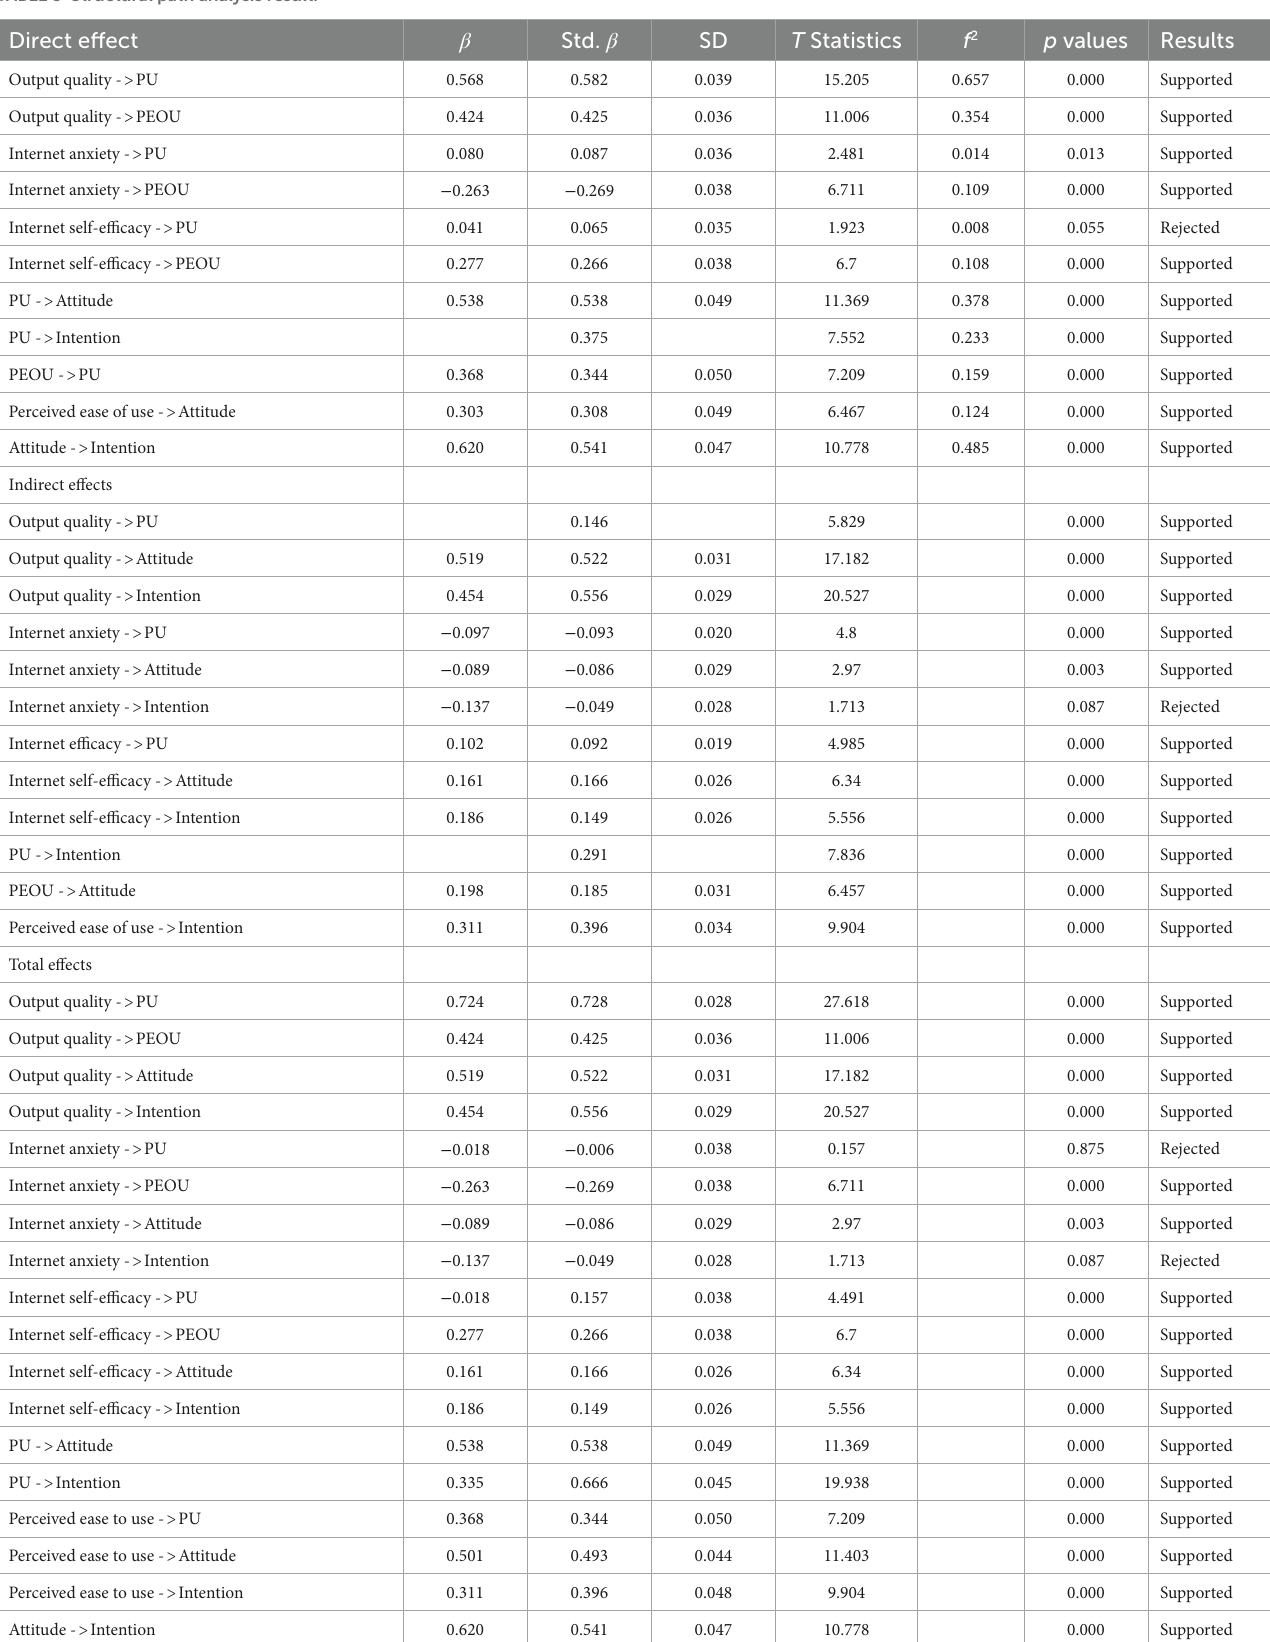
TABLE 5 Structural path analysis